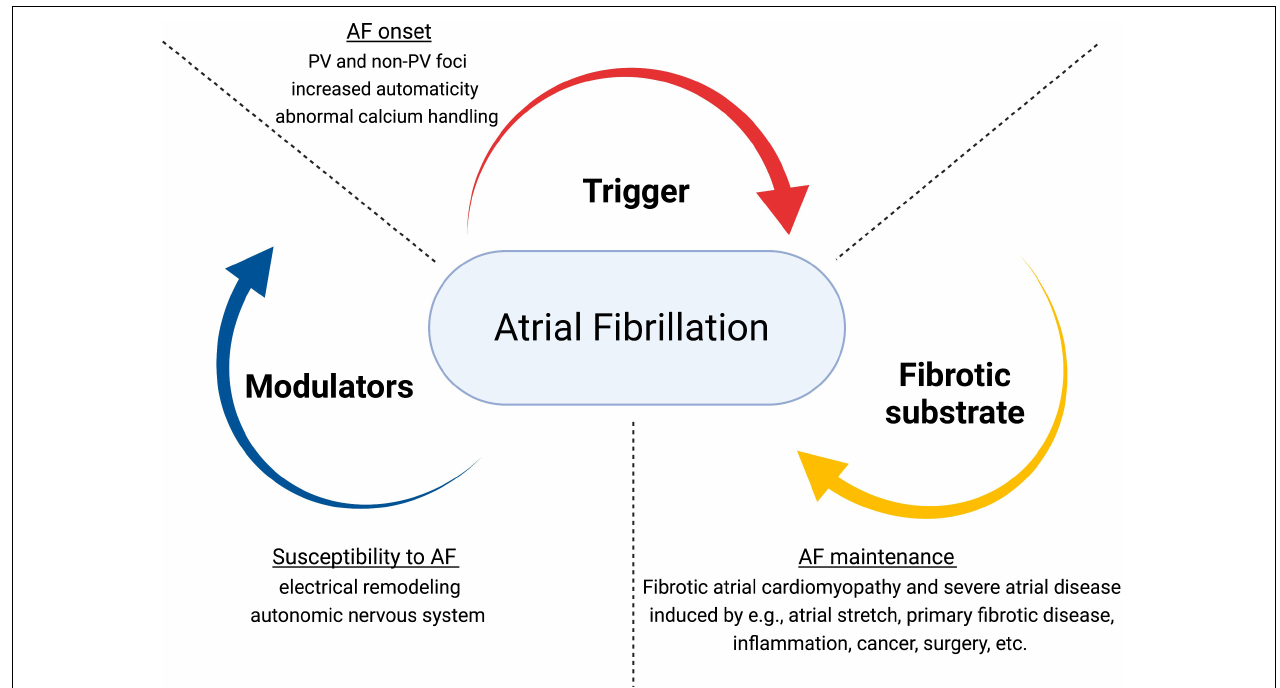
FIGURE 1 | Pathophysiological dynamics in atrial fibrillation. Adapted from Kottkamp and Schreiber (24). JACC Clin Electrophysiol. AF, atrial fibrillation; PV, pulmonary